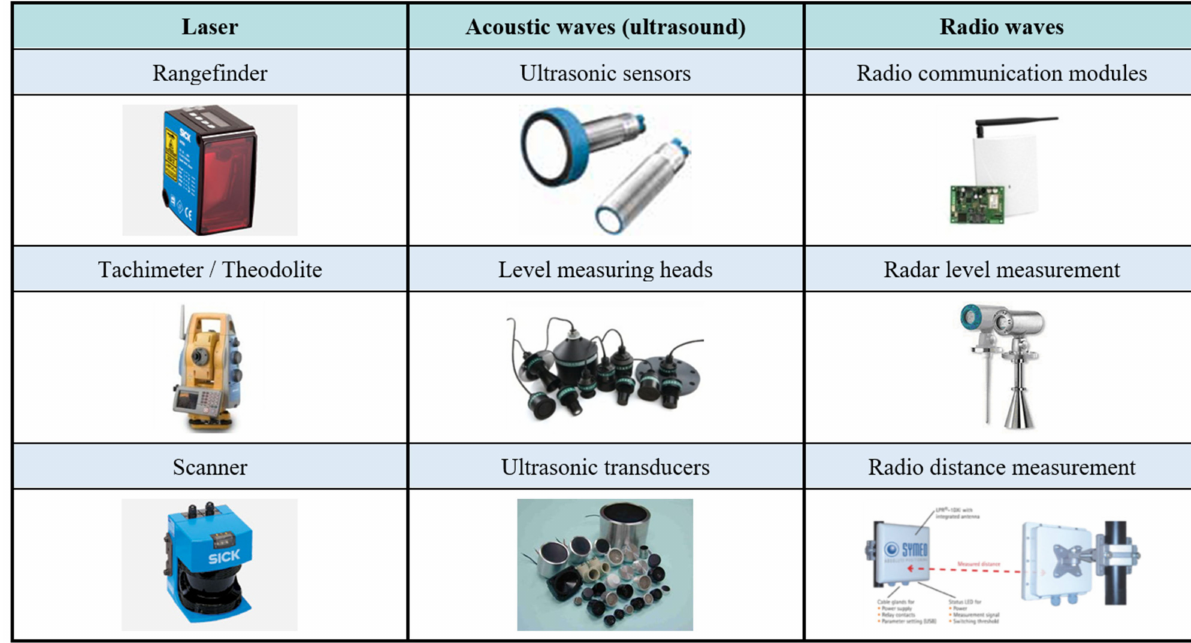
Figure 5. Types of devices using various measurement